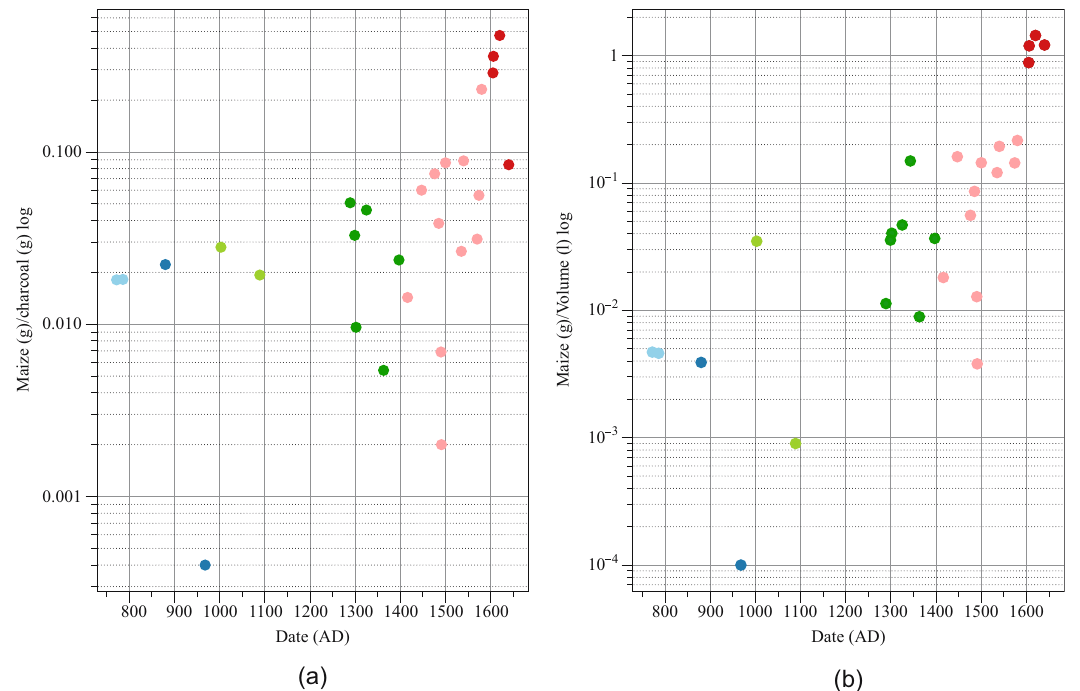
Figure 3: Maize macrobotanical densities, ( a ) maize ( g ) /soil ( l ) , ( b ) maize ( g ) /charcoal ( g ) with logarithmic - scaled y